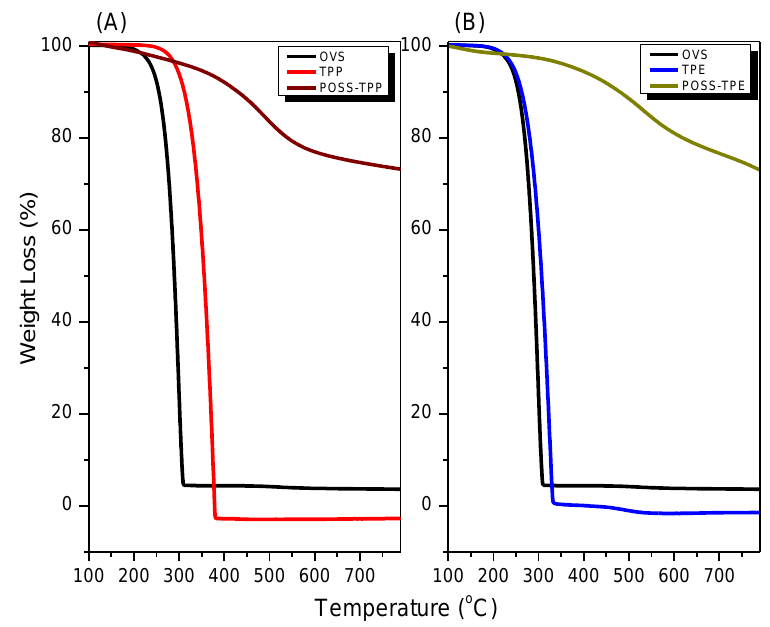
Figure 5. ( A ), ( B ) TGA profiles of OVS, TPP, TPE, POSS-TPP, and POSS-TPE. Figure 5. ( A , B ) TGA profiles of OVS, TPP, TPE, POSS-TPP, and The wide-angle powder X-ray diffraction (WAXD) patterns of POSS-TPP and POSS- TPE (Figure 6) showed a broad peak at 2θ ≈ 22°, indicating that both of these two porous materials possessed amorphous characteristics, with no long-range order compared with the highly crystalline of TPE and OVS. These results displayed the random cross-linking between the TPP and TPE molecules with POSS cage structures [70,71].